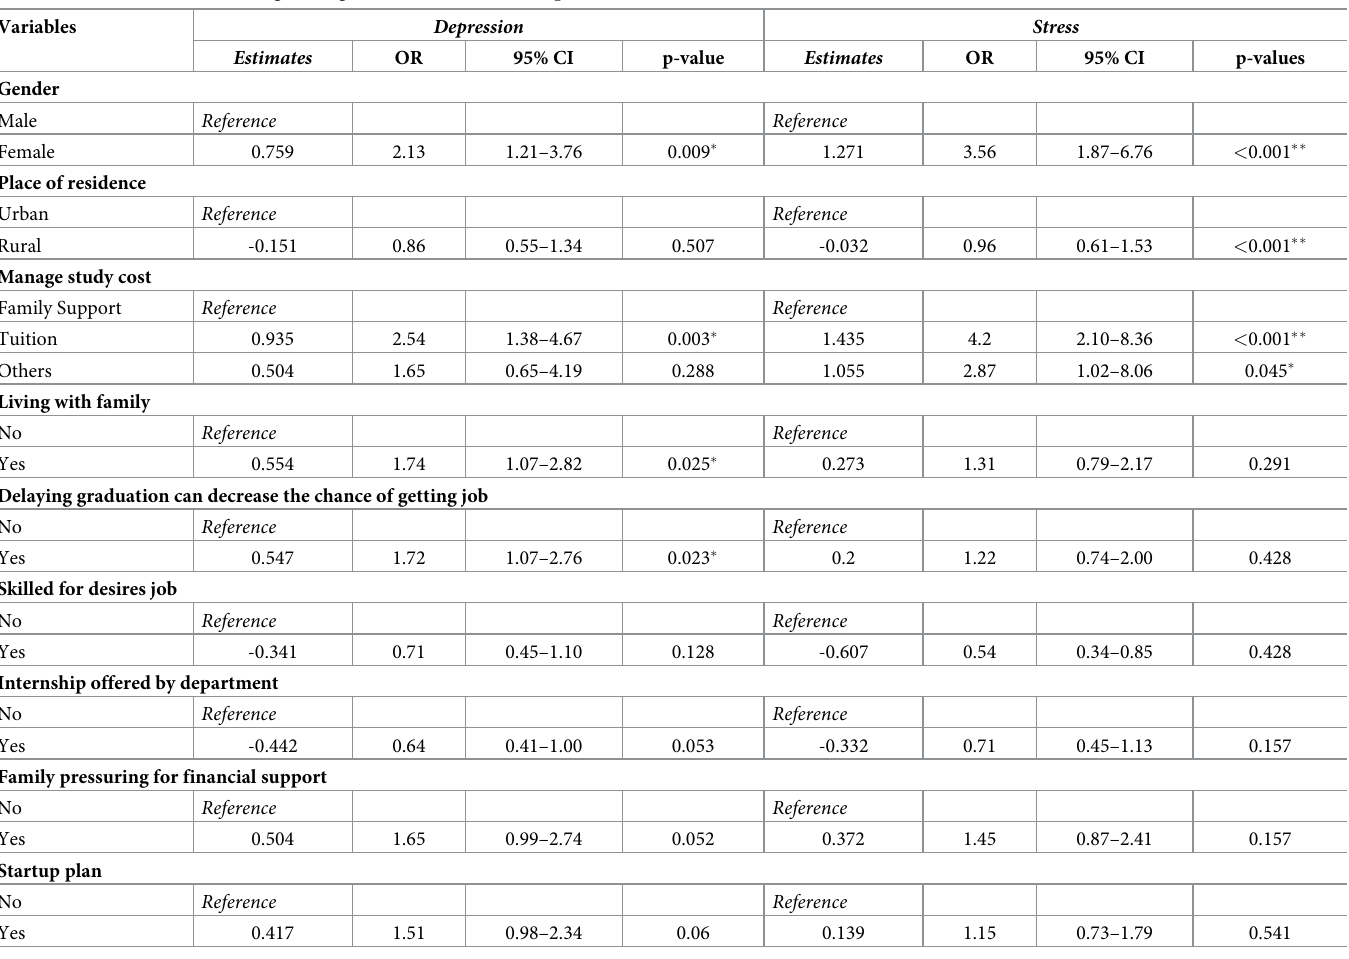
Table 4. Odds ratio (OR) from logistic regression models for the depression and